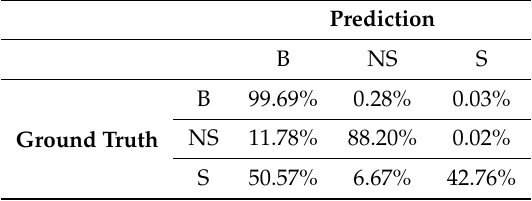
Table 9. Normalized pixel-level Confusion Matrix Deeplab